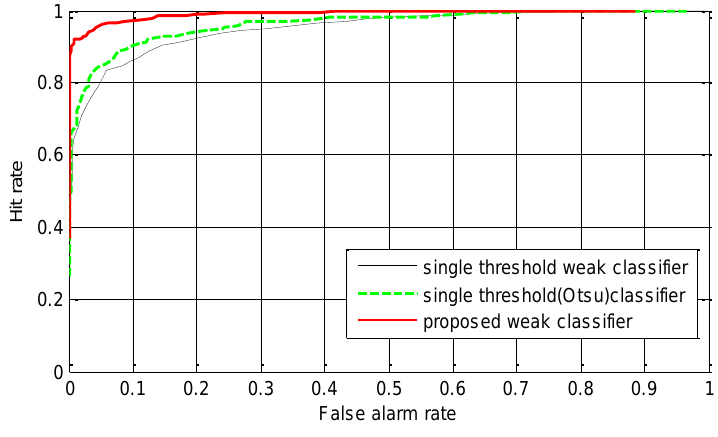
Figure 9. ROC curves for one stage classifiers trained using the proposed weak classifiers and single threshold (derived from average of means and Otsu’s optimal thresholding method) based weak